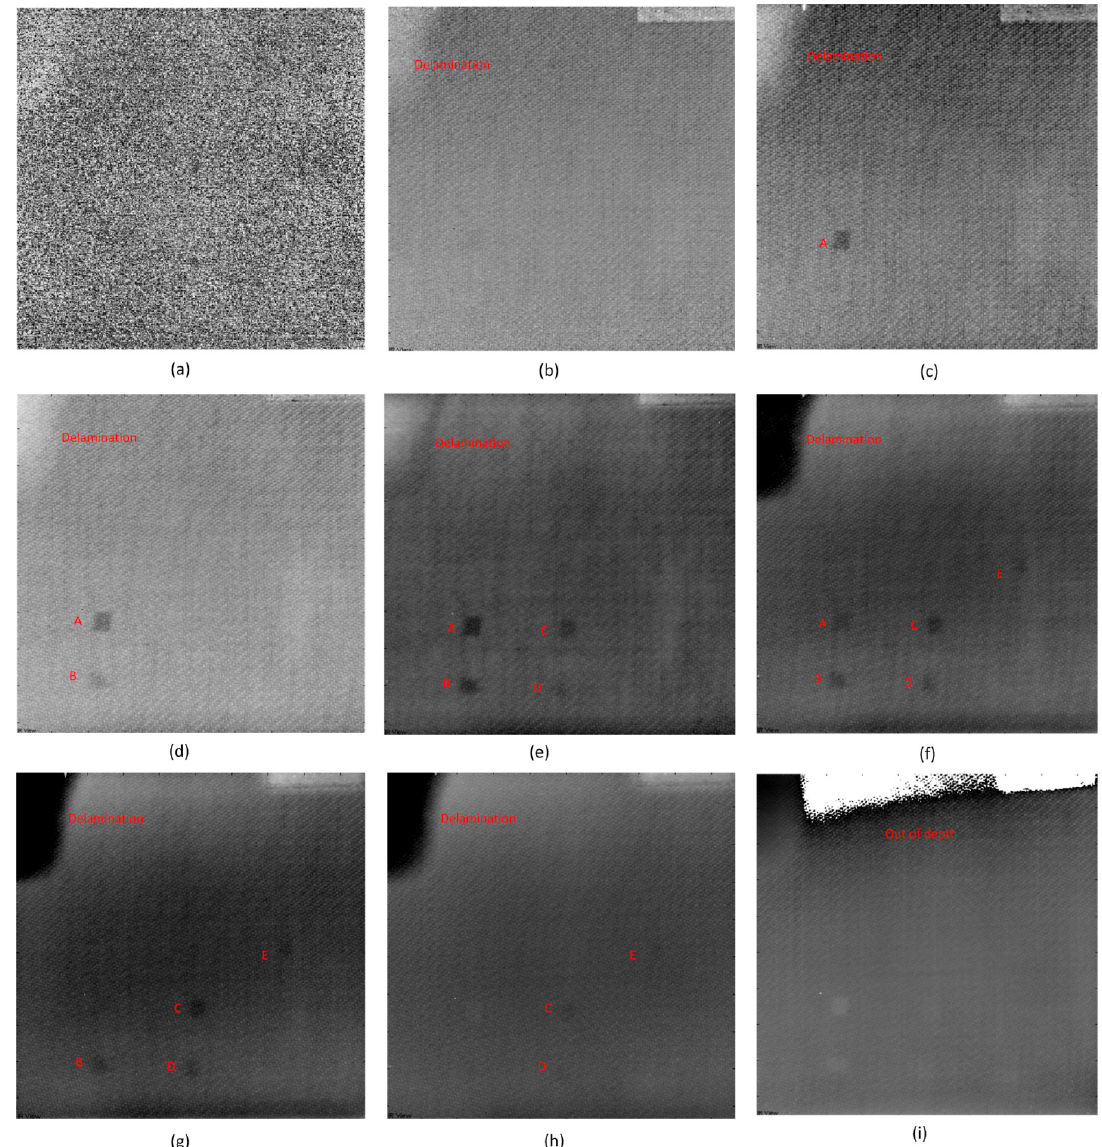
Figure 5: The phase images after Fourier transform, (a) frequency: 3 Hz, (b) frequency: 1 Hz, (c) frequency: 0.6 Hz, Figure 5. The phase images after Fourier transform: ( a ) Frequency: 3 Hz; ( b ) Frequency: 1 Hz; (d) frequency: 0.2 Hz, (e) frequency: 0.1 Hz, (f) 0.05 Hz, (g) 0.04 Hz, (h) 0.03 Hz, (i) 0.02 Hz. ( c ) Frequency: 0.6 Hz; ( d ) Frequency: 0.2 Hz; ( e ) Frequency: 0.1 Hz; ( f ) 0.05 Hz; ( g ) 0.04 Hz; ( h ) 0.03 Hz; ( i ) 0.02